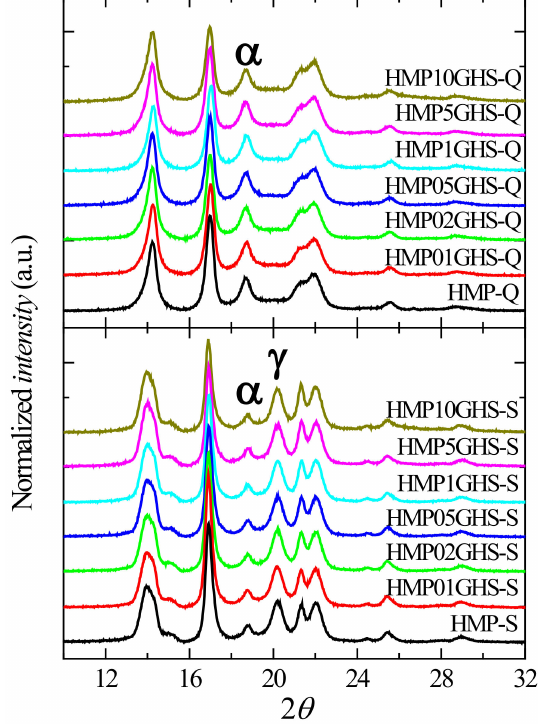
Figure 3. X-ray diffractograms, after subtraction of the amorphous component, for the different nanocomposites with GHS nanofibers under Q and S thermal treatments. Table 1. Degree of crystallinity ( f c XRD ) (%) determined by X-ray diffraction for all the different nanocomposites under the Q and S thermal treatments. Proportion in α and γ forms in the S specimens where these two polymorphs